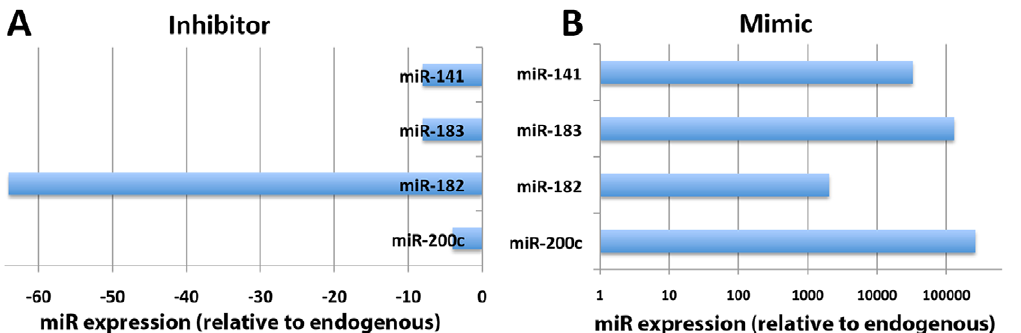
Figure 3. Transfection of inhibitors decrease their corresponding endogenous miRNAs and transfection of mimics increase corresponding miRNAs in SHSY5Y cells. (A) SHSY5Y cells were transfected with hairpin inhibitors for human miR-200c, miR-182, miR-183 and miR-141 individually, the levels of these miRNAs were measured by qPCR, and expressed relative (fold change) to endogenous levels. (B) SHSY5Y cells were transfected with the double stranded miRNA mimics listed on the figure individually, the expression levels were measured by qPCR and the fold changes from endogenous levels were plotted.